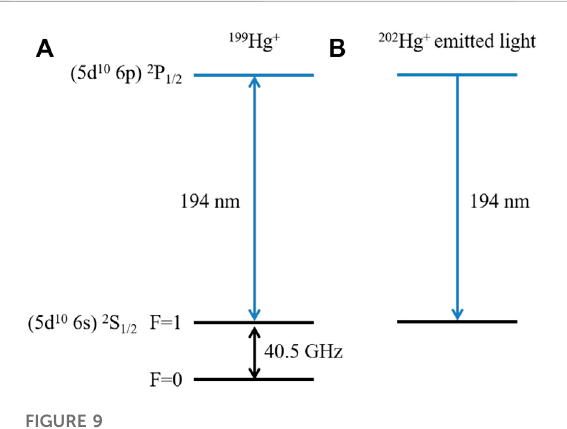
FIGURE 9 Simpli fi ed energy levels of 199 Hg + . (A) The hyper fi ne structure of 199 Hg + ions.The 6 2 S 1/2 (F= 0)and 6 2 S 1/2 (F =1)hyper fi neground states are the upper and lower clock states. (B) The 194 nm light emitted by the 202 Hg +